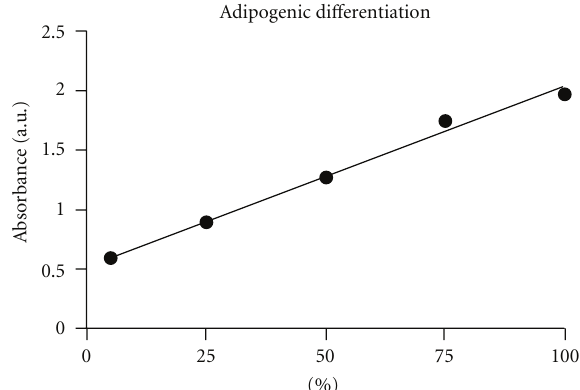
Figure 2: Linear regression showing significant correlation between the percentage of ASCs in the mixed cell population and the increase in Oil Red-O staining ( R 2 = 0 . 979). Error bars represent standard deviation for quadruplicates of each